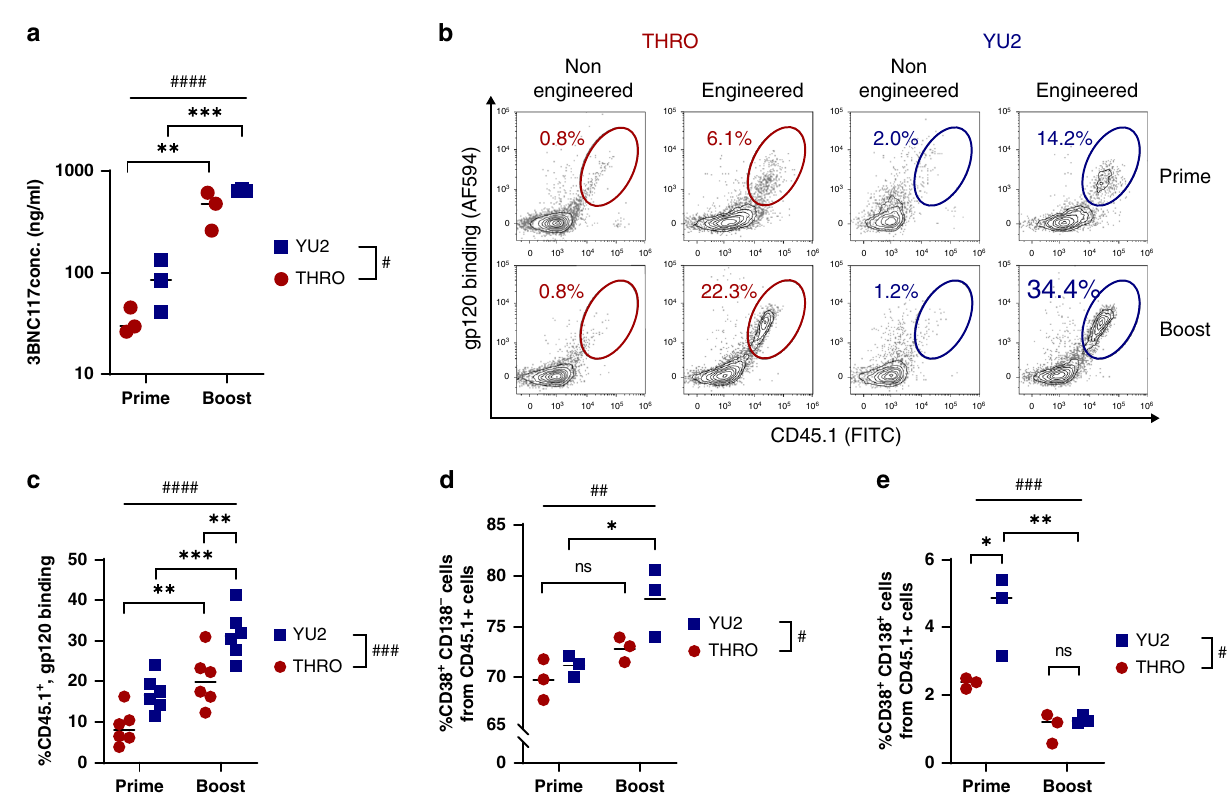
Fig. 4 Adoptively transferred engineered B cells enable memory retention upon immunization. a ELISA of sera collected 14 days following either prime or boost immunization, quanti fi ed using an anti-idiotypic antibody to 3BNC117. ####pv< 0.0001, #pv = 0.0465 for two-way ANOVA and **pv = 0.0024, ***pv = 0.0003 for Tukey ’ s multiple comparison ( n = 3, each dot represents a mouse). b Analysis by fl ow cytometry of CD45.1 expression and gp120 binding in the GCs of mice following prime or boost immunizations, gating on live, singlets, B220 + , GL-7 + . c Quantitation of b . ####pv< 0.0001, ###pv = 0.0003 for two-way ANOVA and ***pv = 0.0008 and **upper = pv = 0.0095 and **lower = pv = 0.0067 for Tukey ’ s multiple comparison ( n = 6, each dot represents a mouse). d , e Analysis by fl ow cytometry of CD38 or CD138 expression among donor derived cells in the spleens of recipient mice after prime or boost immunizations by the gp120 antigens from either the THRO4156.18 (THRO, Red) or the YU2.DG (YU2, Blue) HIV strains, gated on live, singlets, CD45.1 + . ###pv = 0.0003, ##pv = 0.0044, #(D) = pv = 0.0338, #(E) = pv = 0.0125, for two-way ANOVA and **pv = 0.0012, *(D) = pv